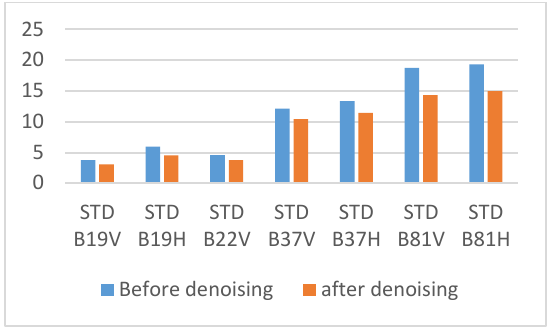
Figure (5). STD for incorporated bands before and after wavelet denoising method